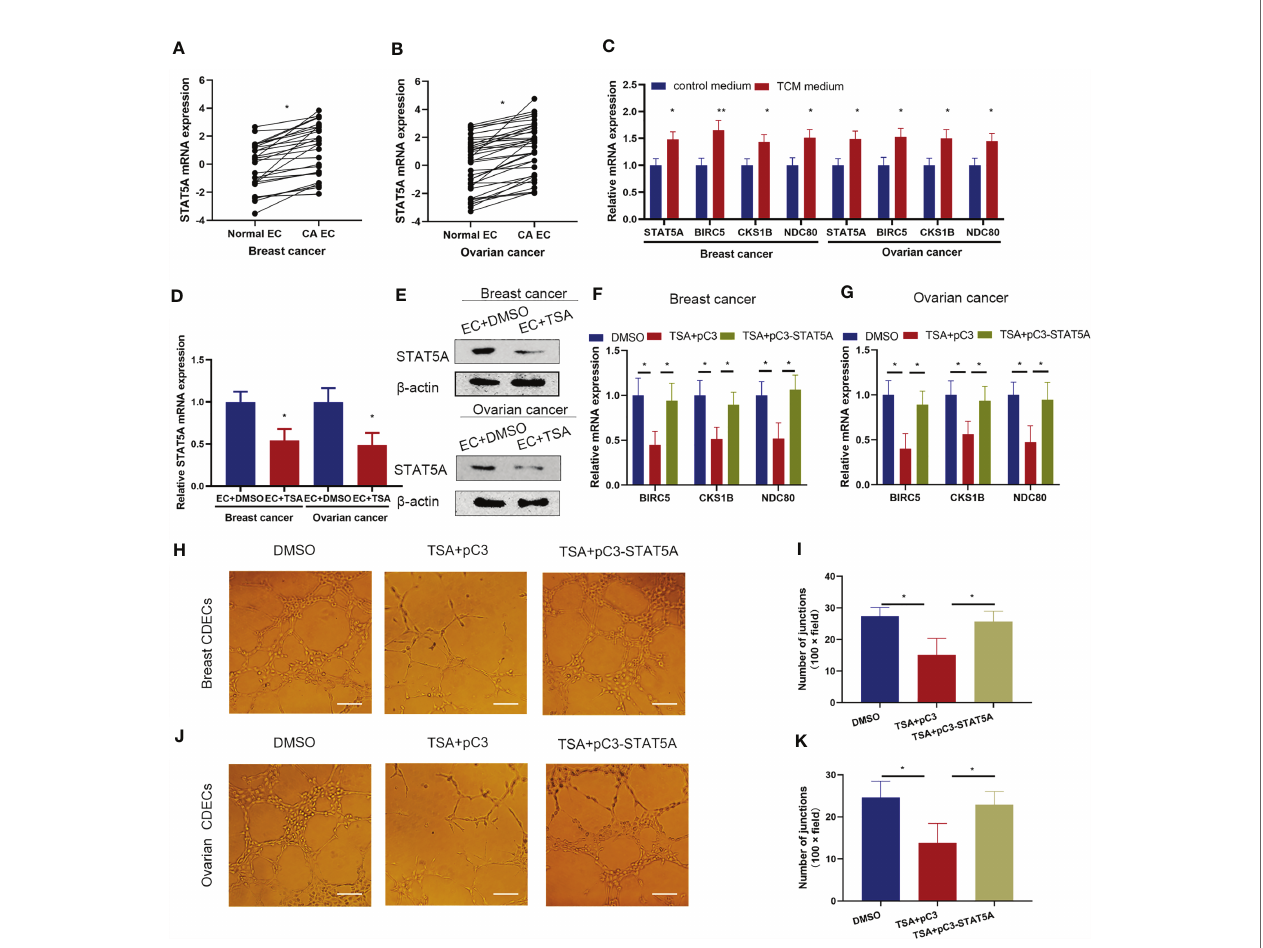
FIGURE 6 | STAT5A also mediated TSA-induced inhibition of tube formation in the cancer angiogenesis model. (A, B) Human normal endothelial cells, breast (A) , and ovarian CDECs (B) were isolated and subjected to qRT-PCR to test the mRNA expression of STAT5A. HUVECs were treated in control medium or breast and ovarian TCM and subjected to qRT-PCR. (C) HUVECs were cultured in the control medium or TCM from human breast and ovarian cancer cells. Expression levels of STAT5A, BIRC5 , CKS1B , and NDC80 were tested by qRT-PCR. (D, E) Human breast and ovarian CDECs were treated with DMSO and TSA. Expression of STAT5A was examined by qRT-PCR (D) and Western blotting assay (E) . (F, G) Human breast (F) and ovarian CDECs were treated with DMSO, TSA, pC3, and pC3-STAT5A. Expression levels of BIRC5 , CKS1B , and NDC80 were measured by qRT-PCR. (H, J) Breast and ovarian CDECs were treated with TSA and the indicated vectors. Representative graphs of tube formation for breast (H) and ovarian (J) CDECs were shown. (I, K) Quanti fi cation data for in vitro tube formation of breast (I) and ovarian (K) . Scale bar 100 m m. Three experiments were replicated. *P < 0.05, **P < 0.01 vs . the control